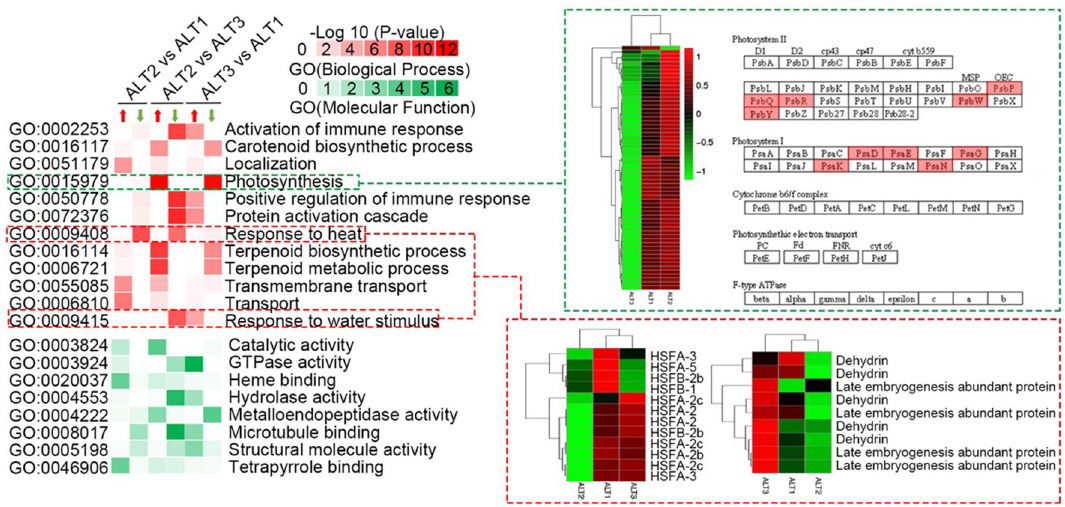
Figure 4. DEGs in photosynthesis and stress response. GO enrichment analysis clustering results (red for the biological process; green for the molecular function) of the up-expressed and down-expressed genes. The clustering analysis results of genes, which belonged to the photosynthesis, response to heat and water stimulus, relative expression levels of these three different groups based on the results of RNA-seq